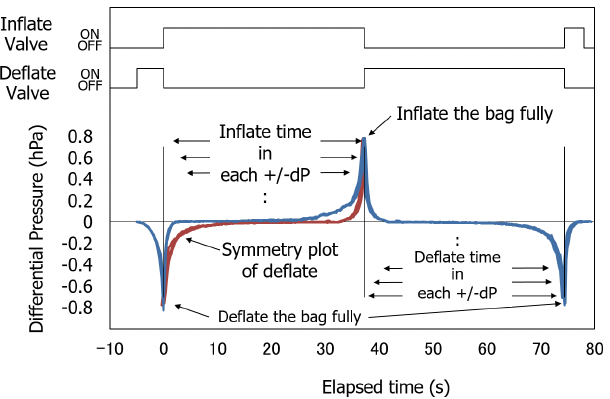
Figure 7. Schematics of pressure differences between the inside and outside of the bag as a function of lapsed time. The blue line plots four time-average difference-pressure values with bag inflation/de- flation changed when the difference pressure reaches 0.8hPa. The red line shows a symmetric reference of deflation to maximum in- flation at an elapsed time of approximately 36s. On/off lines for inflation and deflation are plotted at the